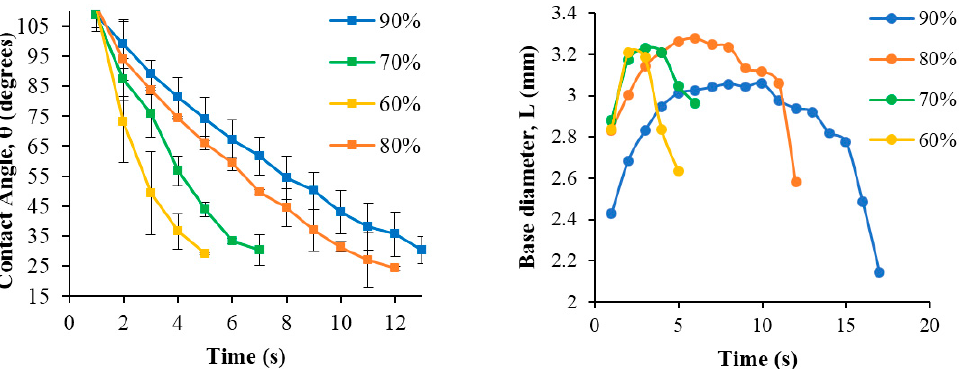
Figure 4. Contact angle and droplet base diameter time dependencies for different concentrations of surfactant (%) on dry audio sponge.